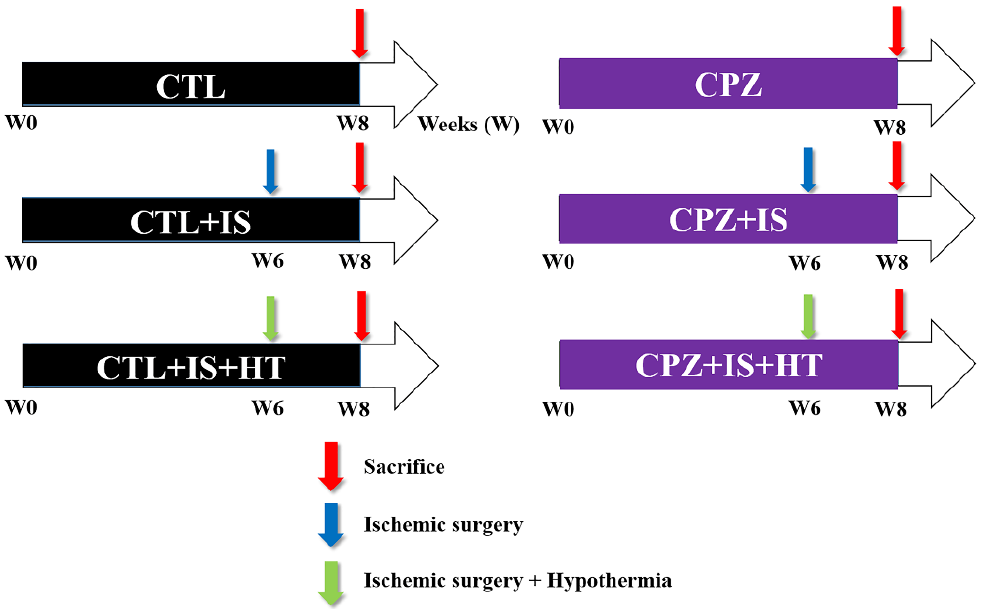
Figure 1. Experimental design of the treatment protocol in normal diet (CTL), cuprizone diet (CPZ), CTL + normothermic ischemic brain surgery (IS), CPZ + IS, CTL + IS + hypothermic treatment (HT), and CPZ + IS + HT groups.